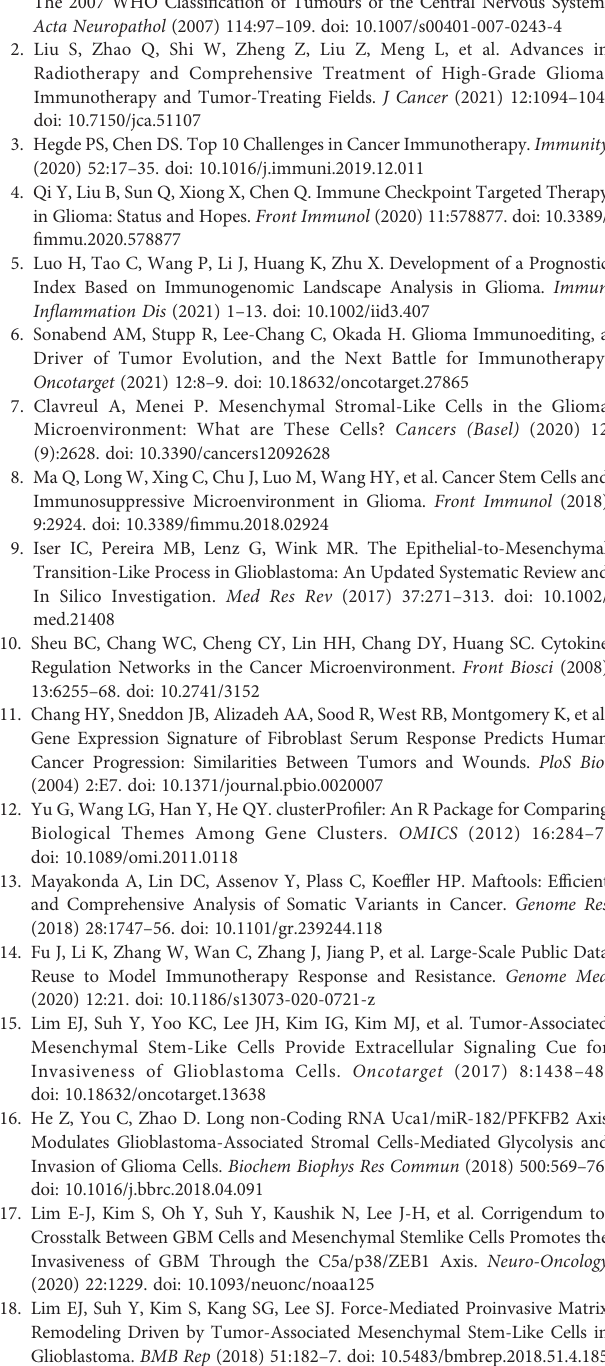
illustrating the differences in immune cell scores between responder and no responder groups in all glioma population ( F for TCGA and G for CGGA) and high- grade glioma population ( H for TCGA and I for